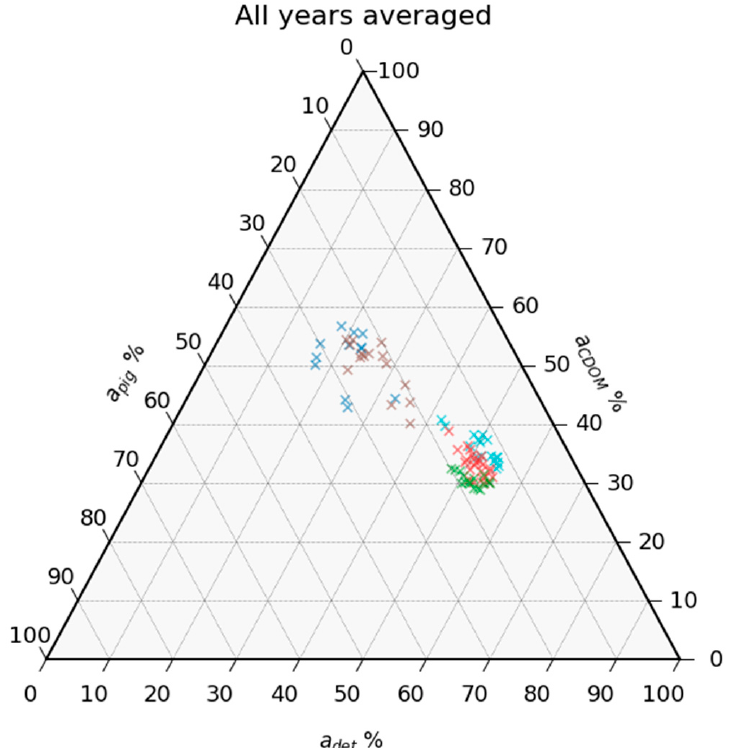
Figure 8. Ternary diagram of the averaged values for all three years for each point of the five study groups. The five groups are plotted in the same colors as in Figure 7. The points from the two land-sourced groups are well-separated from the three inwater groups according to their enhanced CDOM percent